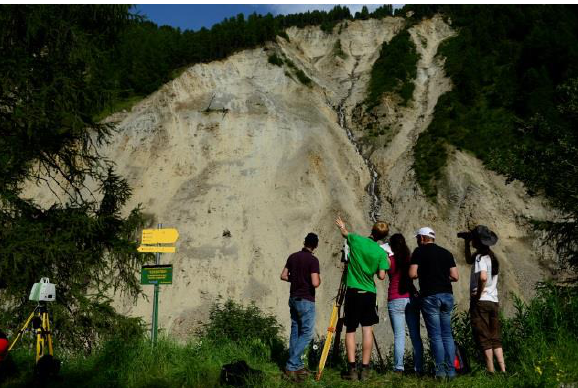
Figure 8. Data acquisition at the test site for mass movement